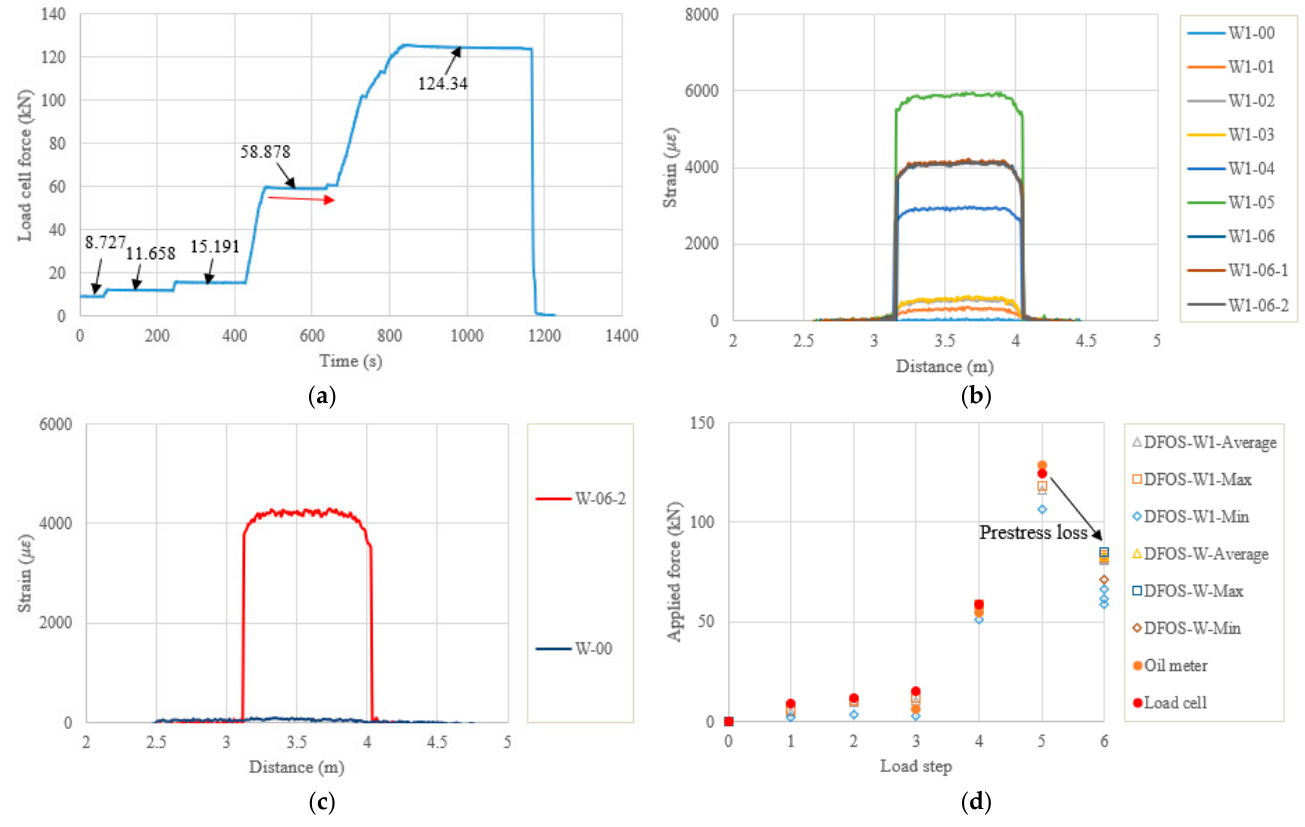
Figure 7. ( a ) Calibrated load cell readings for PC1; ( b ) strain distribution along the strand from one strain fiber (W1); ( c ) the other fiber (W); ( d ) applied force changes at different load steps. Table 4. Prestressing force monitored by load cell and DFOS for PC1 (unit: